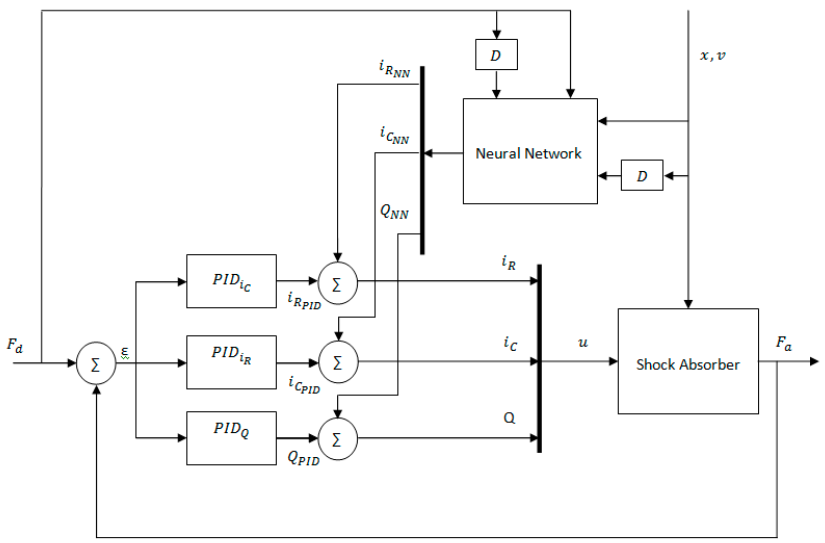
Figure 10. Proposed controller block diagram.